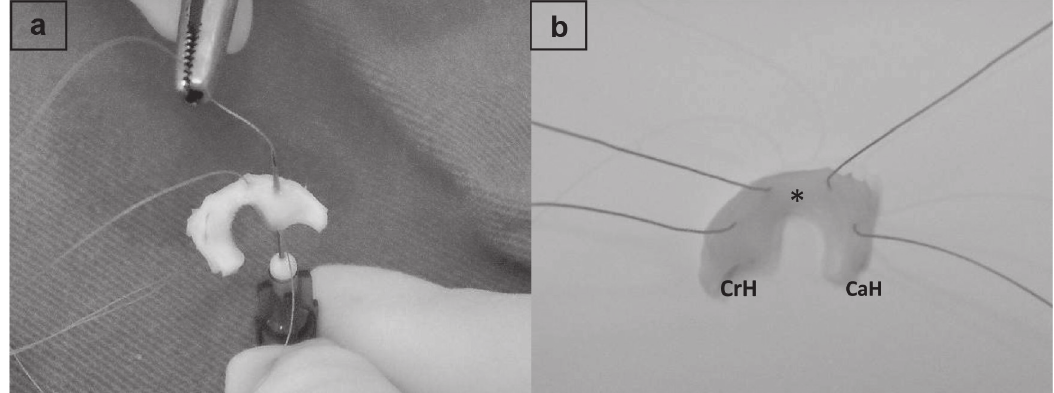
Figure 1 - Surgical sutures applied to the meniscus. a : meniscus being transfixed with two horizontal mattress knots with the aid of hypodermic needle 13x0.45. b : meniscus with suture inserted between the middle third and the cranial horns (CrH) and caudal (CaH). Middle third. (See the colors in the online *